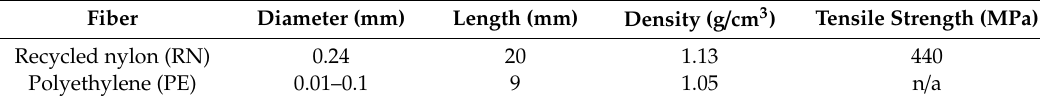
Table 1. Properties of the fibers.